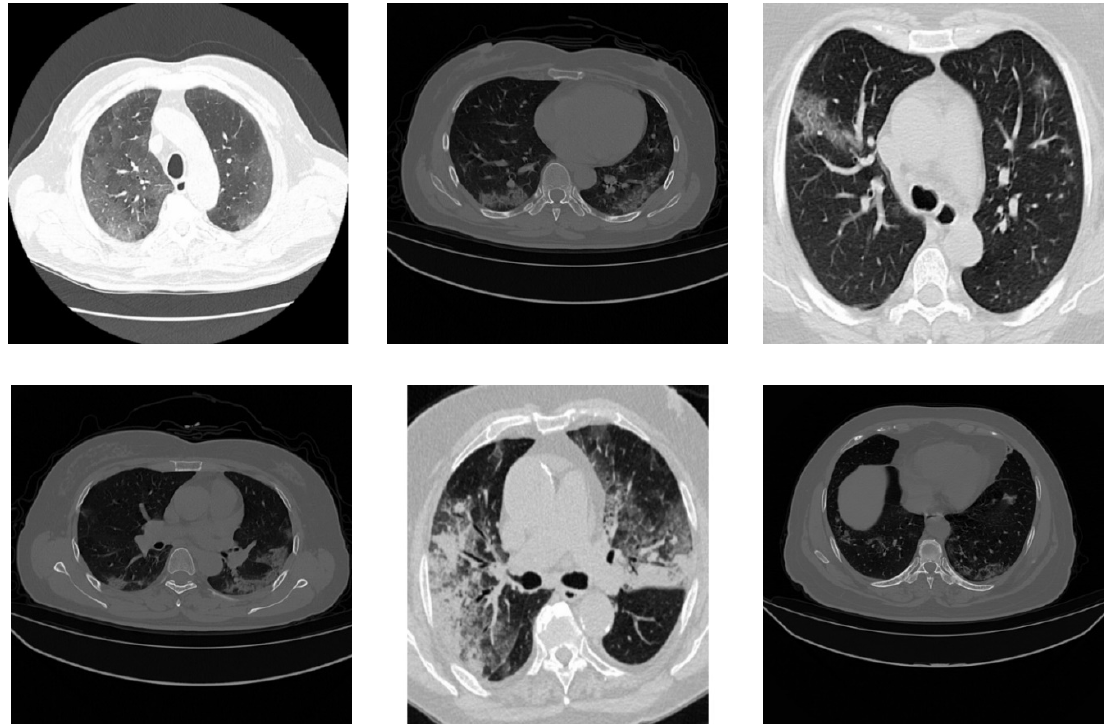
Figure 2. COVID 19 Sample CT scans.